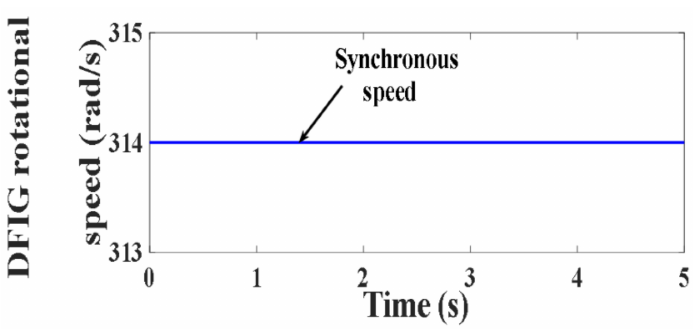
Figure 71. Prime mover operating speeds (rad/s).